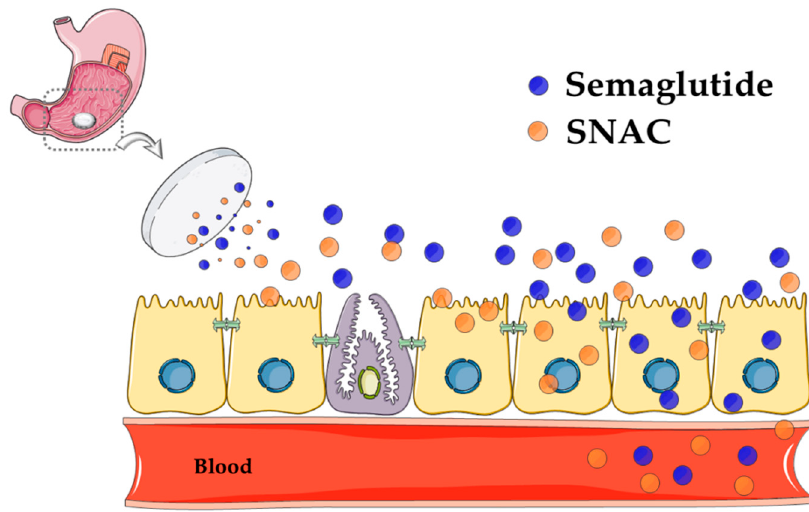
Figure 4. Theory of oral semaglutide absorption, as advocated by Novo Nordisk. Modified from Reference [52]. The diagram represents the proposed mechanism of action of SNAC in inducing transcellular flux of semaglutide across the gastric epithelium of the stomach. The optimum once-daily tablet consists of 14 mg of semaglutide co-formulated with 300 mg of SNAC. After digestion, the tablet erodes rapidly in the stomach, resulting in the release of a highly concentrated amount of SNAC that neutralizes the pH of gastric fluid in the immediate vicinity of the tablet to inactivate pepsin. SNAC is thought to induce semaglutide monomer production and increase gastric epithelial membrane fluidity, but without affecting tight junctions, thereby allowing transcellular passage of semaglutide into systemic circulation. The complex may dissociate at some point in the flux process (Figure 3) due to weak association, but direct evidence for this is scant. Black circles = semaglutide; white circles = SNAC. Image made using a template from Servier Medical Art under a Creative Commons Attribution License.